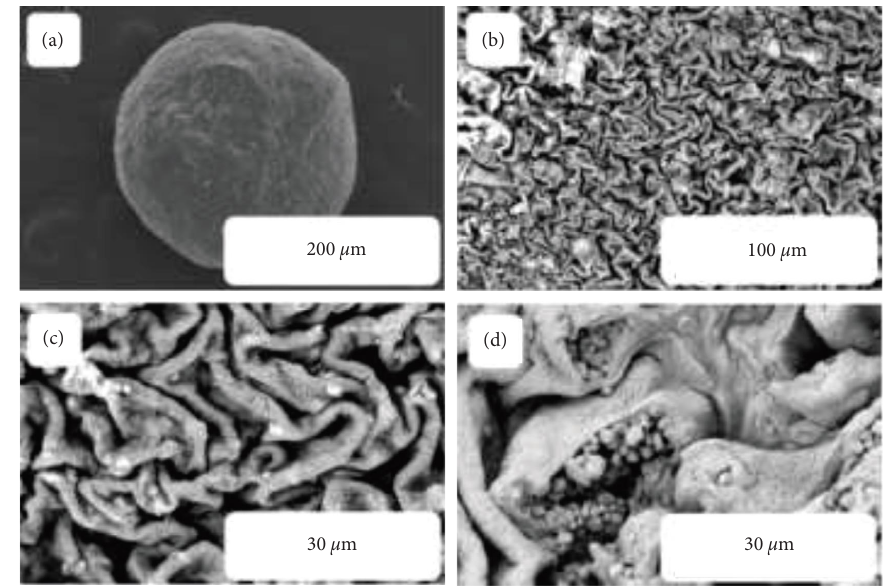
Figure 7: SEM analysis of the samples: (a, b, c, and d) were SEM spectra of CMC-LTO-EGDE-ME.